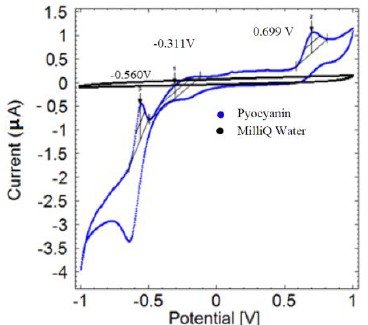
Figure 1. Cyclic voltammogram of 500 µM pyocyanin (blue) compared to the MilliQ water control (black) using a scan rate of 0.05 V/s. No signals are generated from cyclic voltammetry of MilliQ water, while pyocyanin reveals a characteristic profile with oxidation peaks at −0.560 V, −0.311 V and 0.699 V (arrows) measured versus the Ag reference electrode.